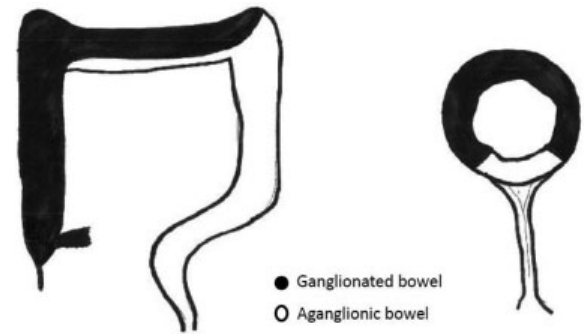
Fig. 3 Pictorial representation of the pattern of